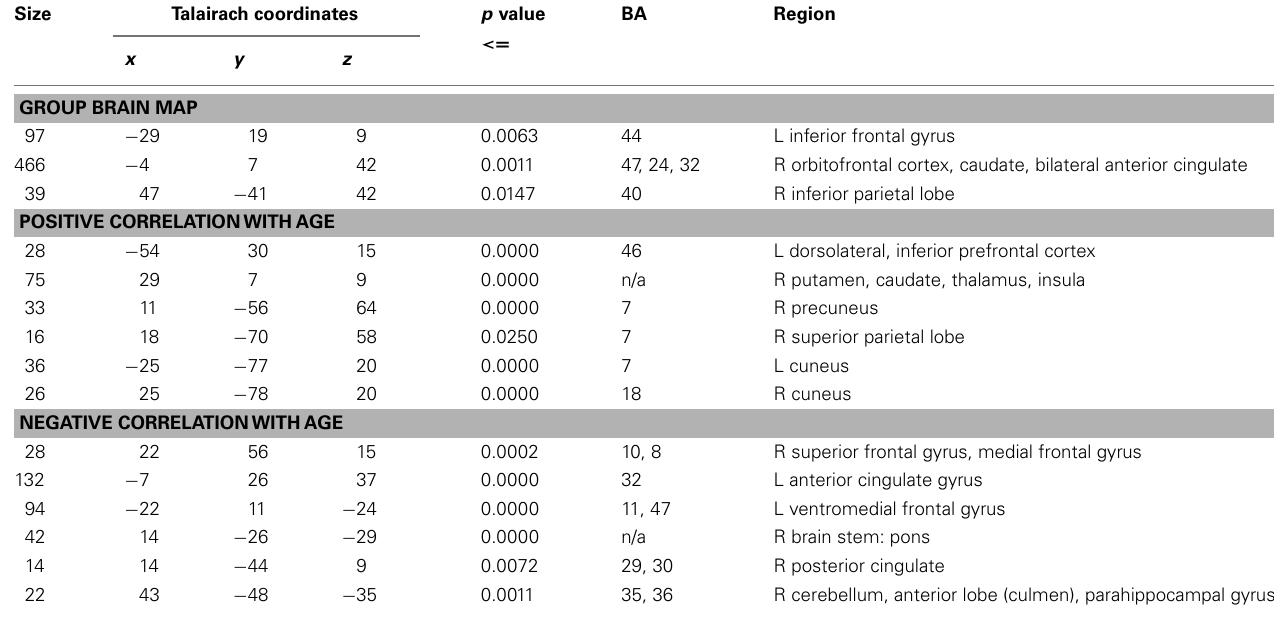
Table 1 | Clusters of significant activation for all subjects during contrast of temporal discrimination and order as well as the results of a whole-brain regression analysis showing brain areas where activation has positive and negative linear correlation with age during time discrimination contrast with IQ as a